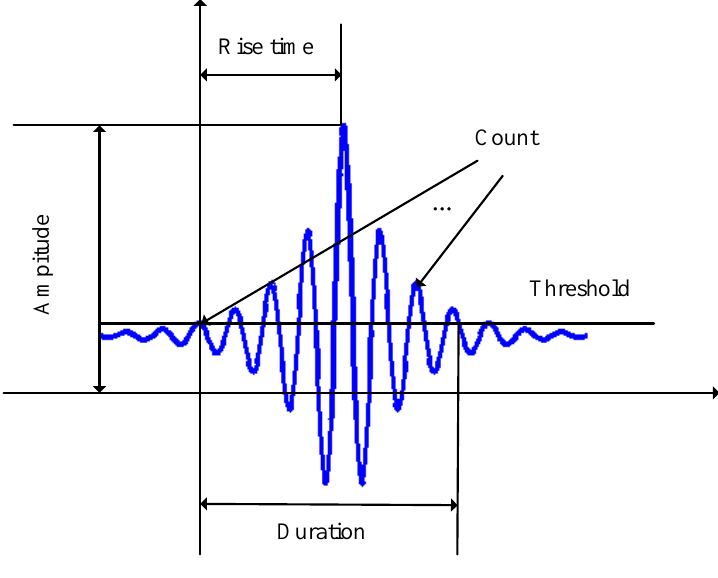
Figure 2. Typical parameters of AE